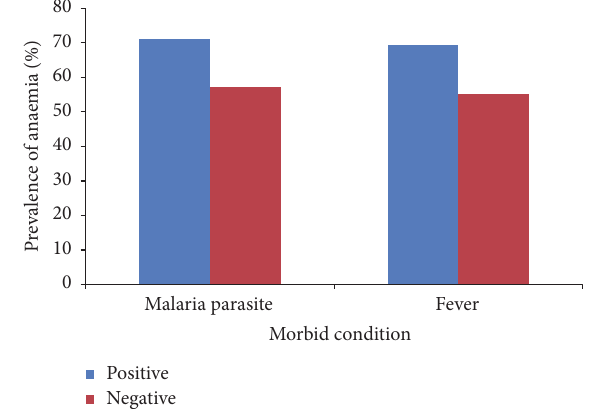
Figure 3: Prevalence of anaemia as affected by malaria parasite and fever status. Positive denotes (i) positive for malaria parasite (participantswithpositiveslideformalariaparasite)and(ii)positive for fever (participants with temperature ≥ 37.5 ∘ C). Negative denotes (i) negative for malaria parasite (participants with negative slide for malaria parasite) and (ii) negative for fever (participants with temperature < 37.5 ∘